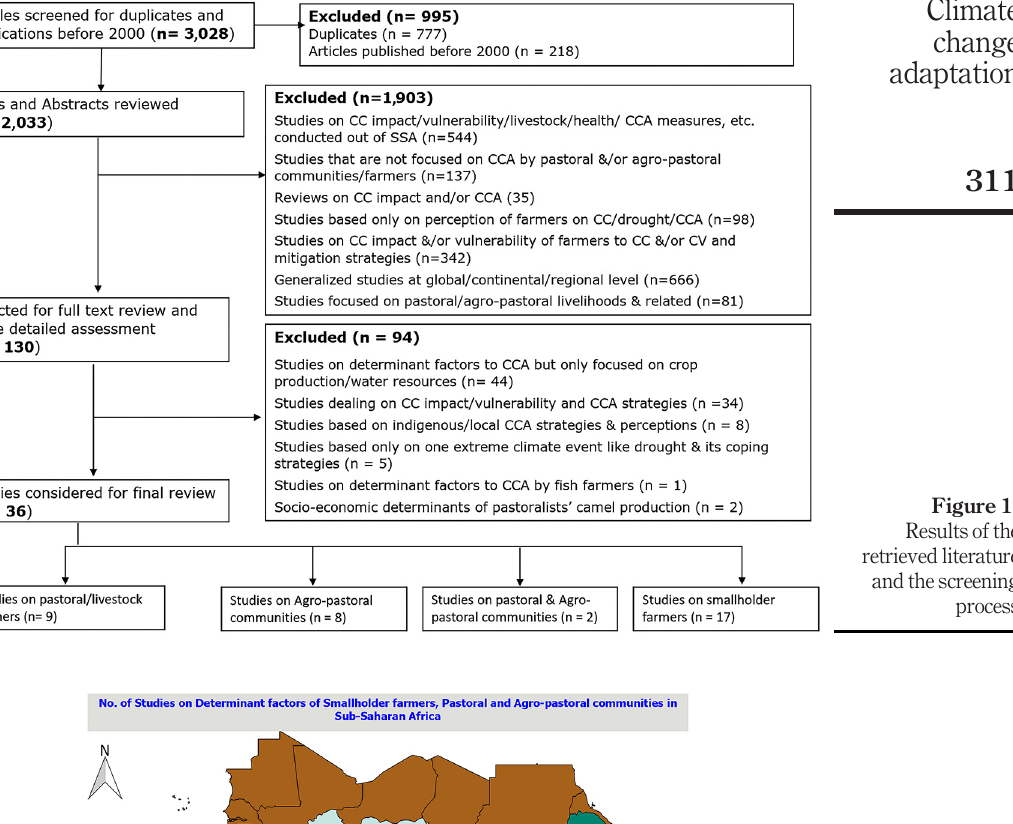
Figure 2. Distribution